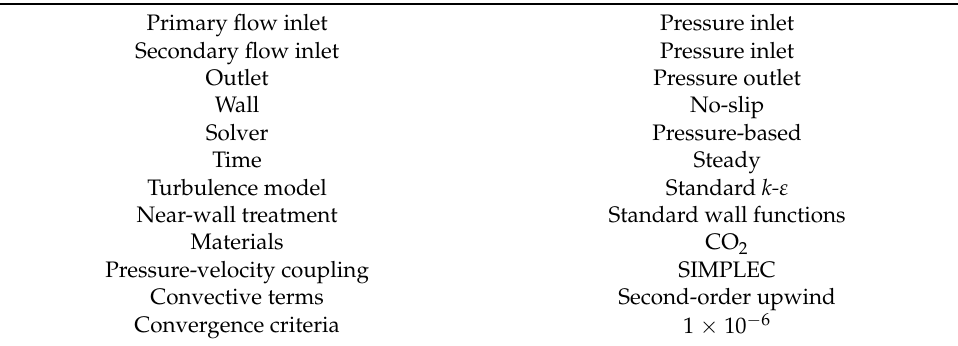
Table 2. Simulation